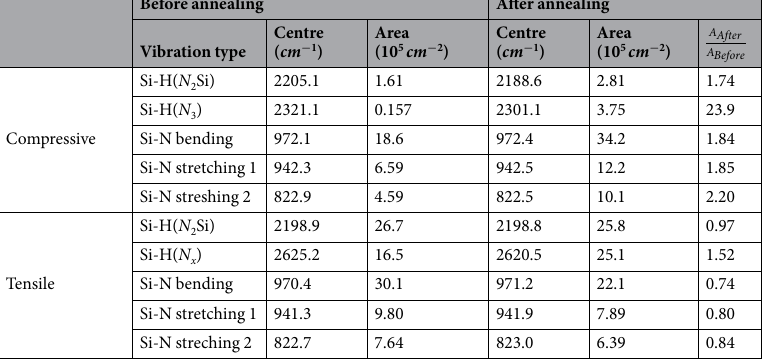
Before annealing After annealing